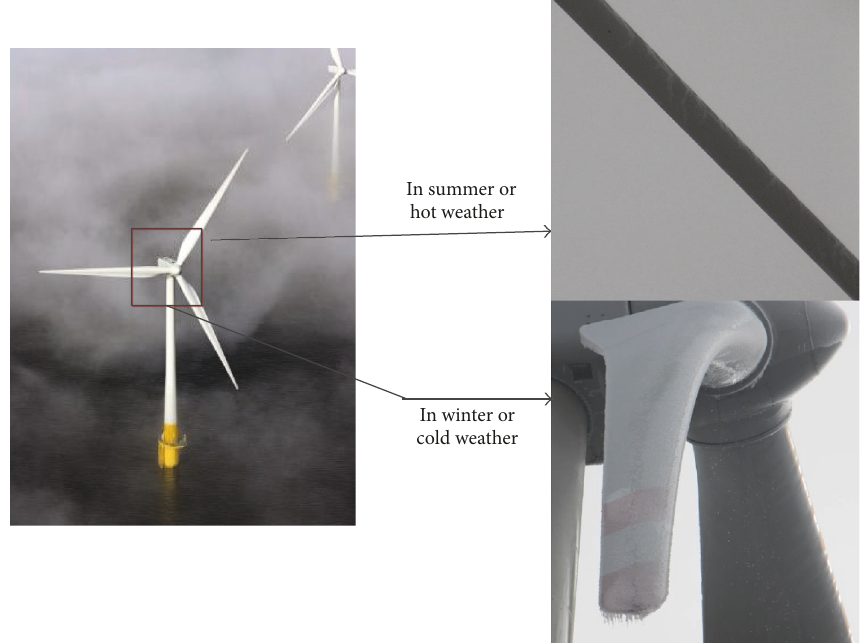
Figure 1: Offshore wind turbines shrouded in foggy and water film on blade surface and icing on blade